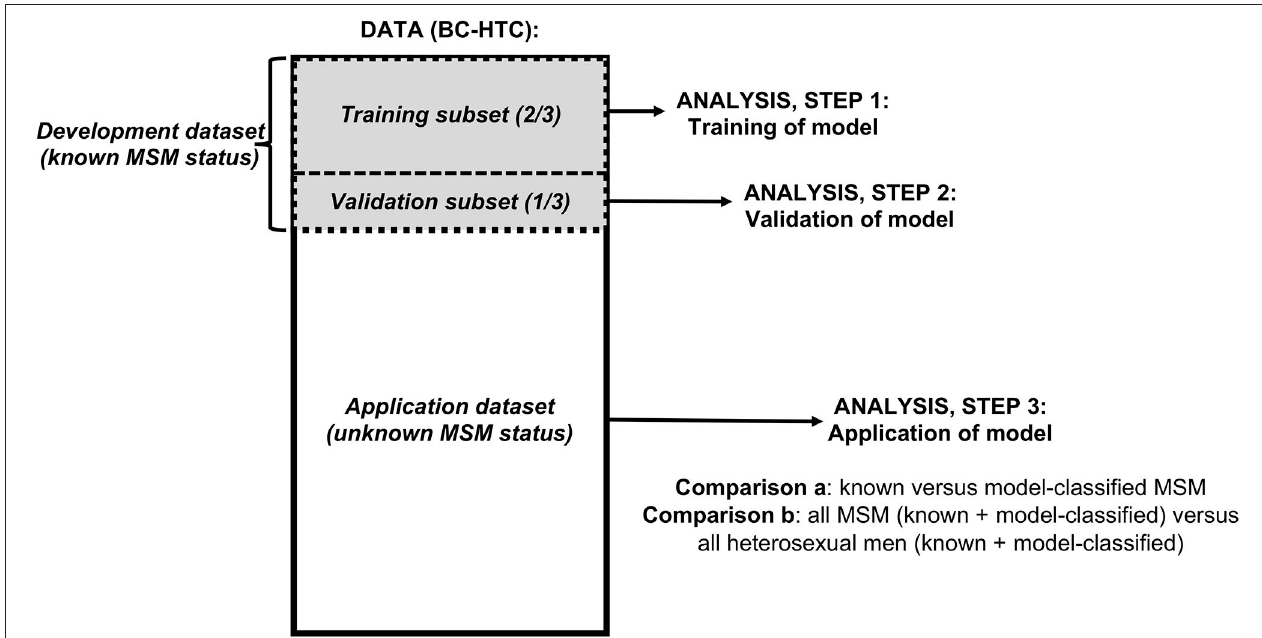
FIGURE 1 | Flowchart of data and analyses used in study of a computable phenotype for men who have sex with men (MSM) within the British Columbia Hepatitis Testers Cohort (BC-HTC).